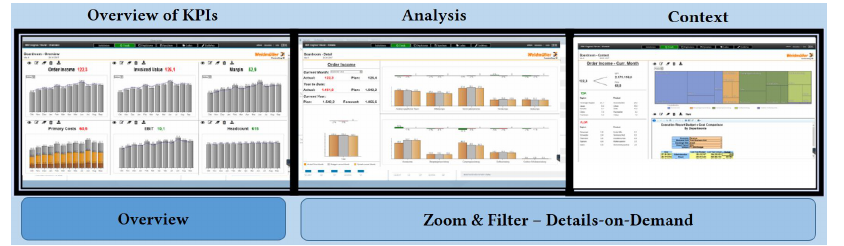
Figure 2. The Digital Boardroom: A